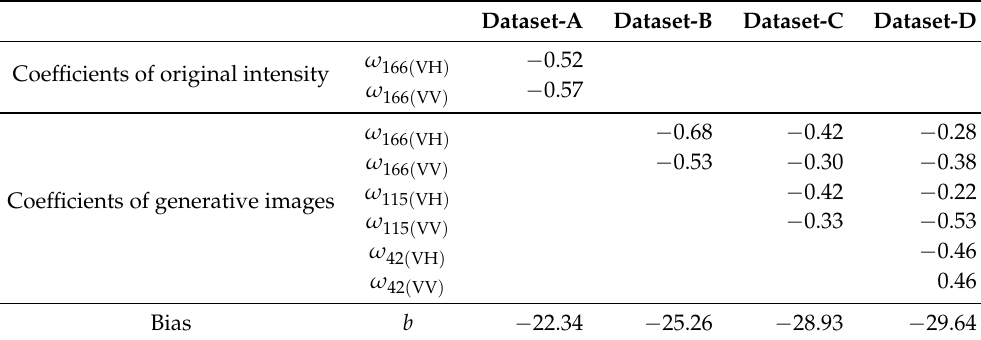
Table 2. Coefficients and bias estimated from training